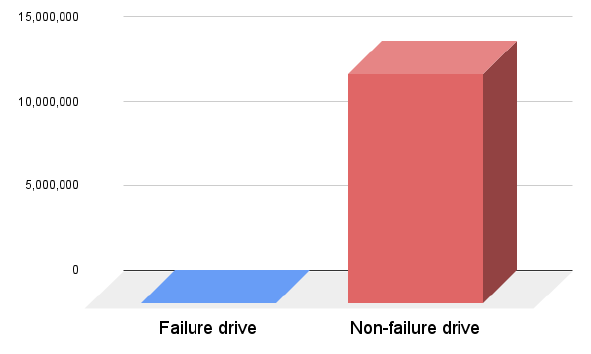
Figure 2. Data distribution.